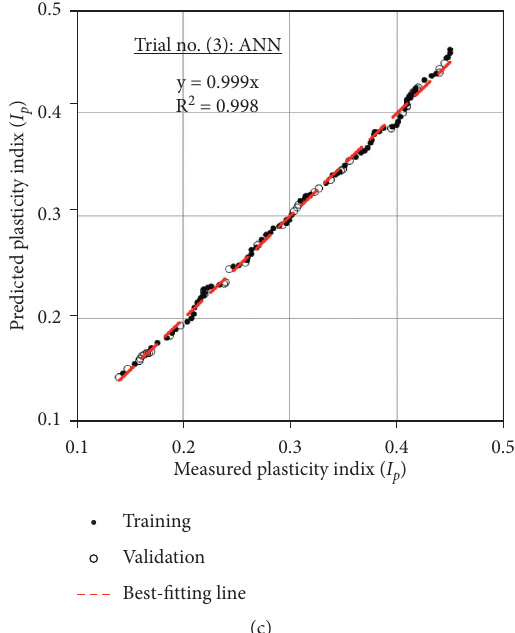
Figure 9: Relation between the predicted and calculated ( I p ) values using the developed GP and ANN models. Table 6: Accuracies of the developed GP and ANN models. Error % Soil property Model no. Output formula Training